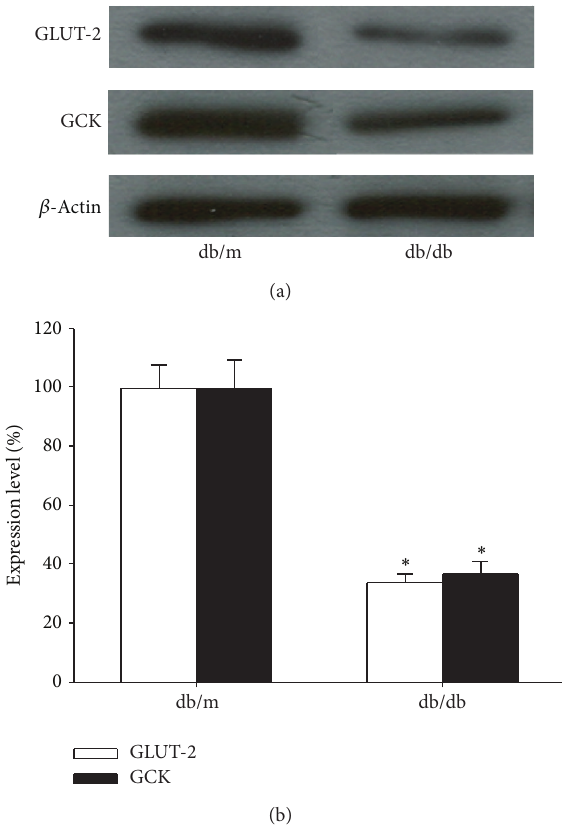
Figure 8: Expression of GLUT-2 and GCK protein in islets from db/m mice or db/db mice. Lysates from freshly isolated islets were analyzed for GLUT-2 and GCK expression by Western blot analysis. Results represent the mean ± SD. Blots from one representative experiments are shown. ∗ 𝑃 < 0.05 versus db/m group, 𝑛 = 5 .